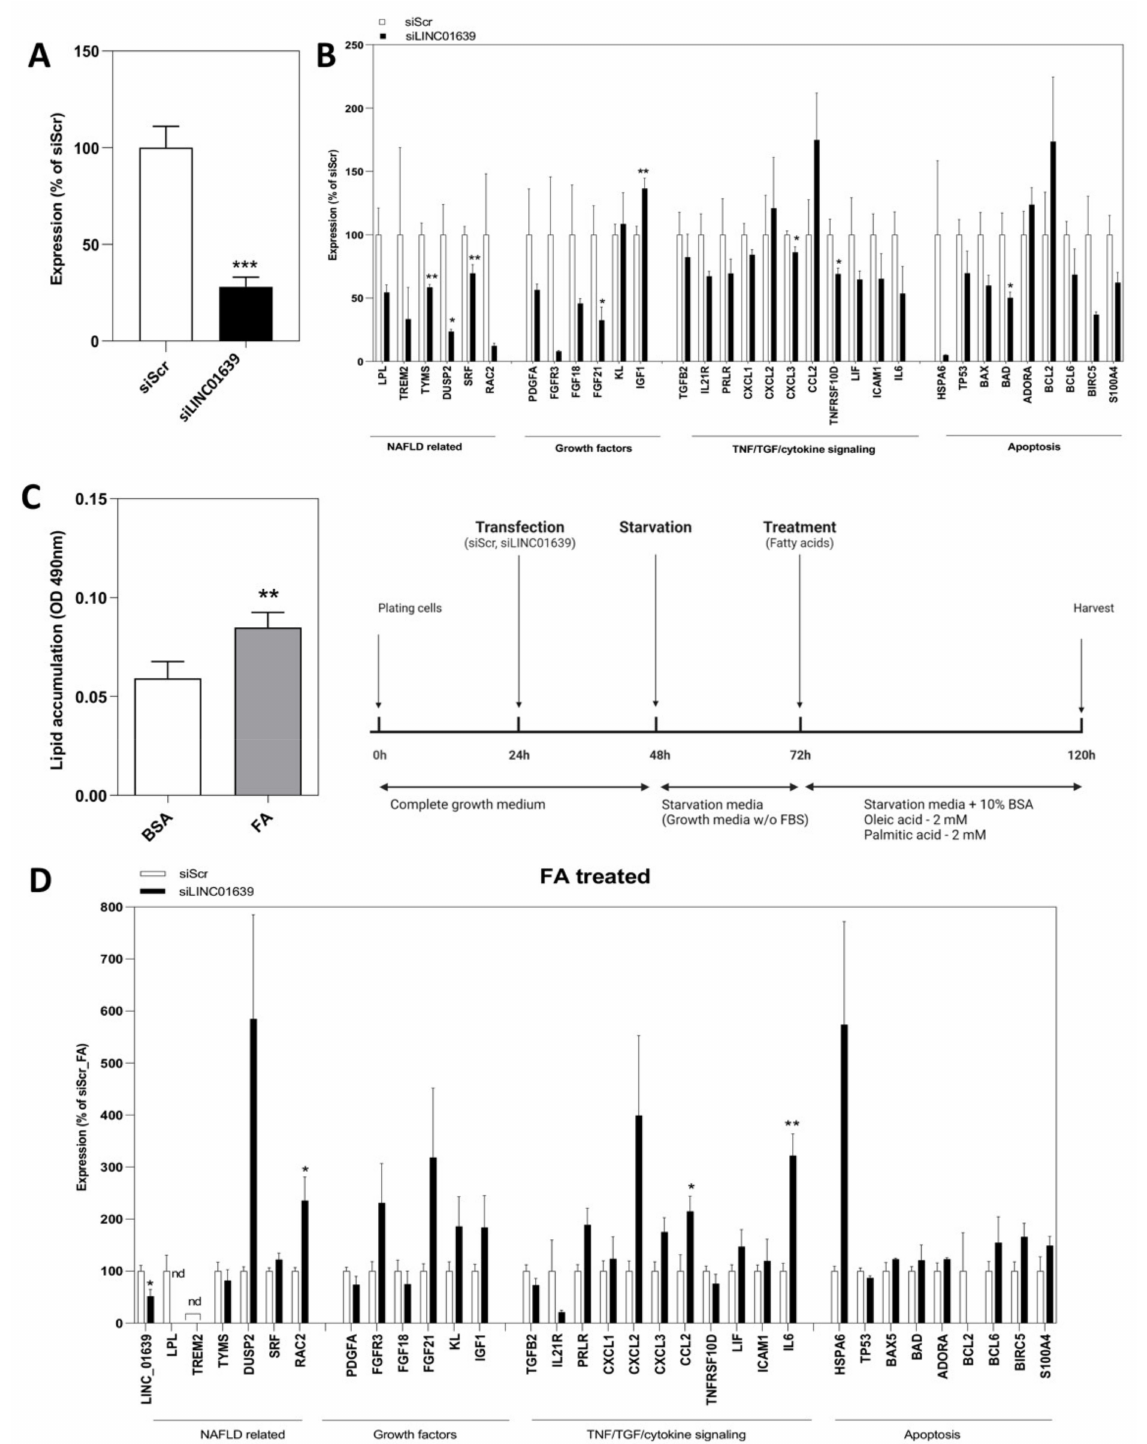
Figure 4. Role of LINC01639 in regulation of gene expression in hepatocytes. ( A ) Silencing of LINC01639 in Huh-7 cells, Error bars represent mean ± S.E.M. *** p < 0.001. ( B ) Gene expression profile after silencing of LINC01639 in Huh-7 cells. n = three biological replicates. * p < 0.05; ** p < 0.01. ( C ) NAFLD cellular model. Huh-7 cells treated with a mixture of fatty acids (FA) consisting of 2 mM oleic acid and 2 mM palmitic acid at the ratio of 1:1. The schematic experimental timeline for NAFLD cellular model generation is presented. ( D ) Gene expression profile of NAFLD cellular model upon silencing of LINC01639 n = three biological replicates. * p < 0.05; ** p < 0.01. nd = not